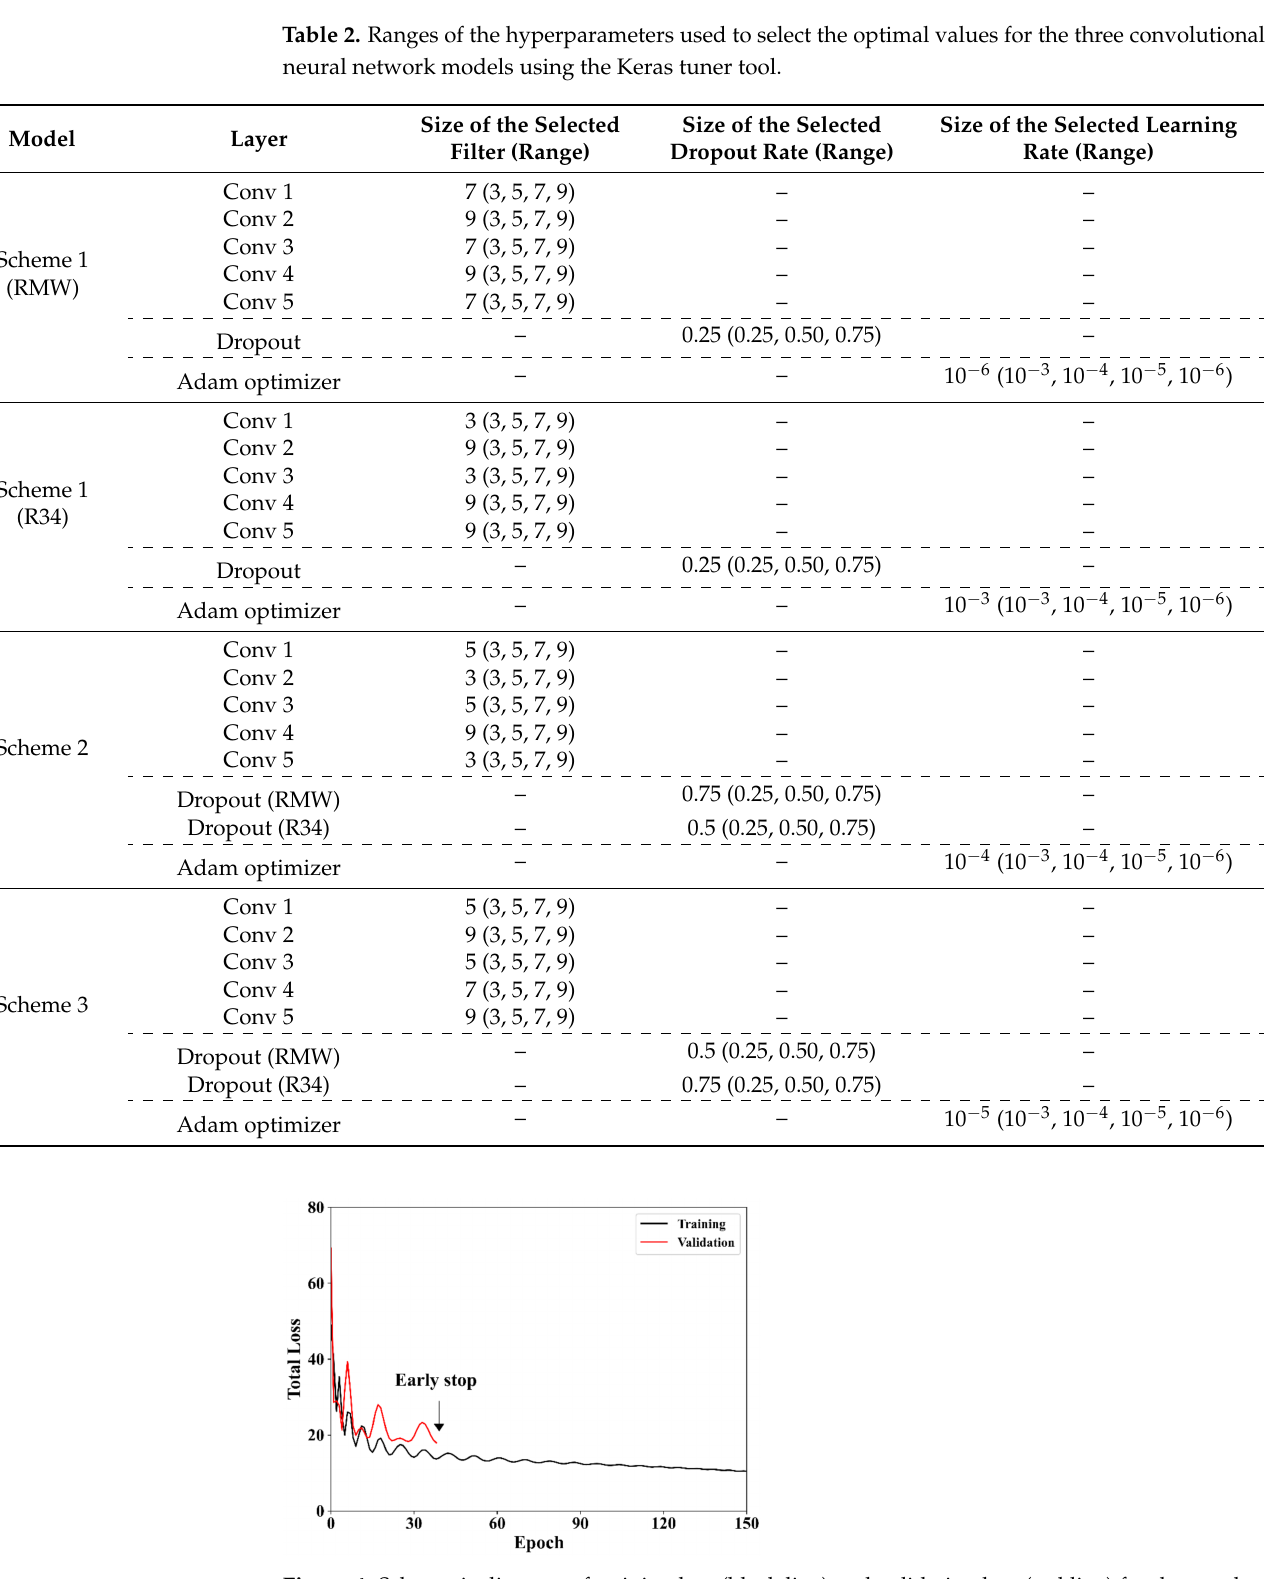
Figure 4. Schematic diagram of training loss (black line) and validation loss (red line) for the number of epochs (1 epoch = [training set size ÷ batch size] × iterations). As the epochs progressed, the training loss continuously decreased and converged to zero, while the validation loss increased or became constant in a specific epoch (i.e., overfitting). Training was stopped early in the epoch in which the minimum (or constant) validation loss appeared to prevent